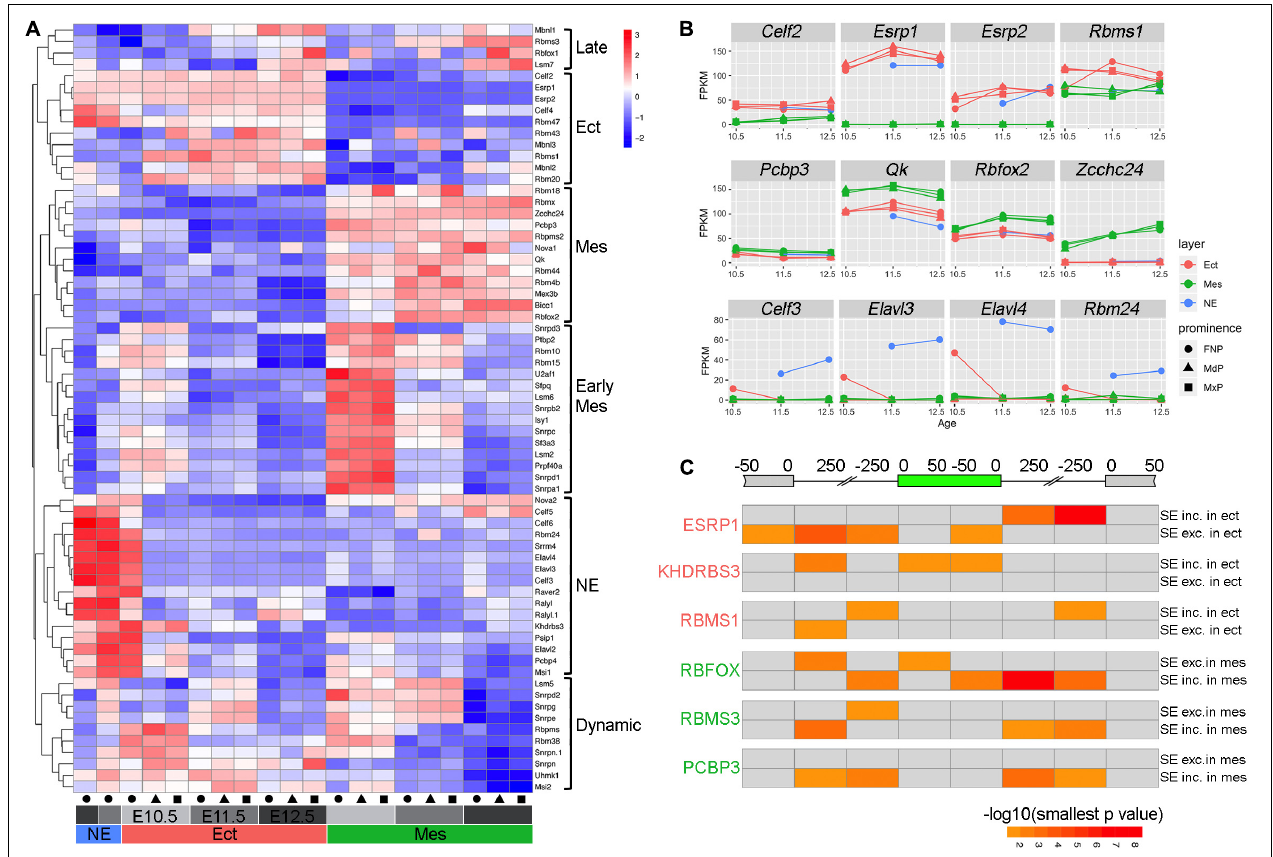
FIGURE 5 | Regulatory program for alternative splicing during facial development. (A) Heatmap showing differentially expressed splicing factors during facial development (maximal FPKM across all samples > 1, adjusted p -value < 0.01, and maximal fold change across all samples > 2). Each row shows the scaled expression of a presumptive splicing regulator with the color scale at the top right, while each column represents average expression of a sample based on three biological replicates. The columns are annotated at the bottom with colors for tissue layers (red for Ect, green for Mes, and blue for NE), gray intensity for ages (light for E10.5, intermediate for E11.5, and dark for E12.5), and shapes for prominences (circle for FNP, triangle for MdP, and rectangle for MxP). The differentially expressed splicing factor programs are bracketed on the right side of the heatmap as late program in both ectoderm and mesenchyme (Late), pan ectoderm program (Ect), pan mesenchyme program (Mes), early mesenchyme program (Early Mes), nasal epithelial program (NE), and a program with complex dynamic change over time in ectoderm and mesenchyme (Dynamic). (B) Expression profiles for genes with higher expression in ectoderm (top panels), mesenchyme (middle panels), or nasal epithelium (bottom panels) during facial development. For each panel, the gene name is shown on the top, and the x and y axes show embryonic day and averaged FPKM from the three biological replicates for each sample, respectively. Layers are shown with colors (red for Ect, green for Mes, and blue for NE), while prominences are distinguished by shapes (circle for FNP, triangle for MdP, and rectangle for MxP). (C) Heatmap for RNA binding protein motifs on and around the skipped exon summarized from rMAP2 predictions of SE events from E11.5 MxP Ect_vs_Mes comparison ( Supplementary Figure 15A ). At the top, the diagram of the gene shows the skipped exon in green, the upstream and the downstream exons in gray. The sequences associated with the skipped exon are divided into eight regions according to the distance to the closest splicing junction. For each panel, the respective RBP is shown on the left. The top row is the significance [–log10(smallest p -value)] of the predicted RBP motif for each region in events with higher PSI in ectoderm/lower PSI in mesenchyme (SE inc. in ect/SE exc. in mes), and the bottom row is the significance of the predicted motif for each region in events with lower PSI in ectoderm/higher PSI in mesenchyme (SE exc. in ect/SE inc. in Mes). The color scale is shown in the bottom right, with darker color indicating more significant. The gray color indicates non-significant (smallest p -value > 0.05). Please note that in the same region, if it’s significant in both SE inc. in ect/SE exc. in mes and SE exc. in ect/SE inc. in Mes, only the more significant one is shown in the heatmap, while the less significant one is shown in gray. Ect, ectoderm; FNP, frontonasal process; Mes, mesenchyme; MdP, mandibular prominence; MxP, maxillary prominences; NE, nasal epithelium; SE, skipped